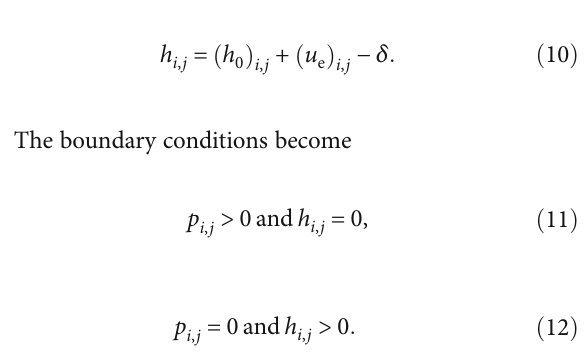
2 R 𝛿 : Indentation depth (movement of the rigid sphere) Figure 10: Illustration of the physical parameters in Equations (30) and